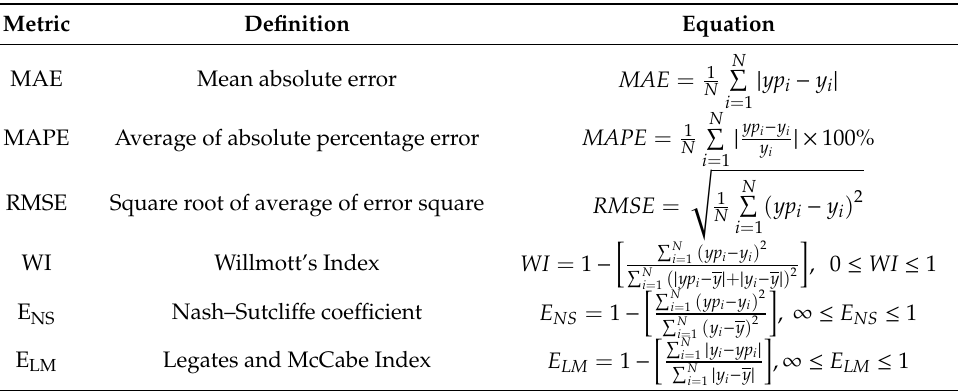
Table 1. The definition of error evaluation indexes.